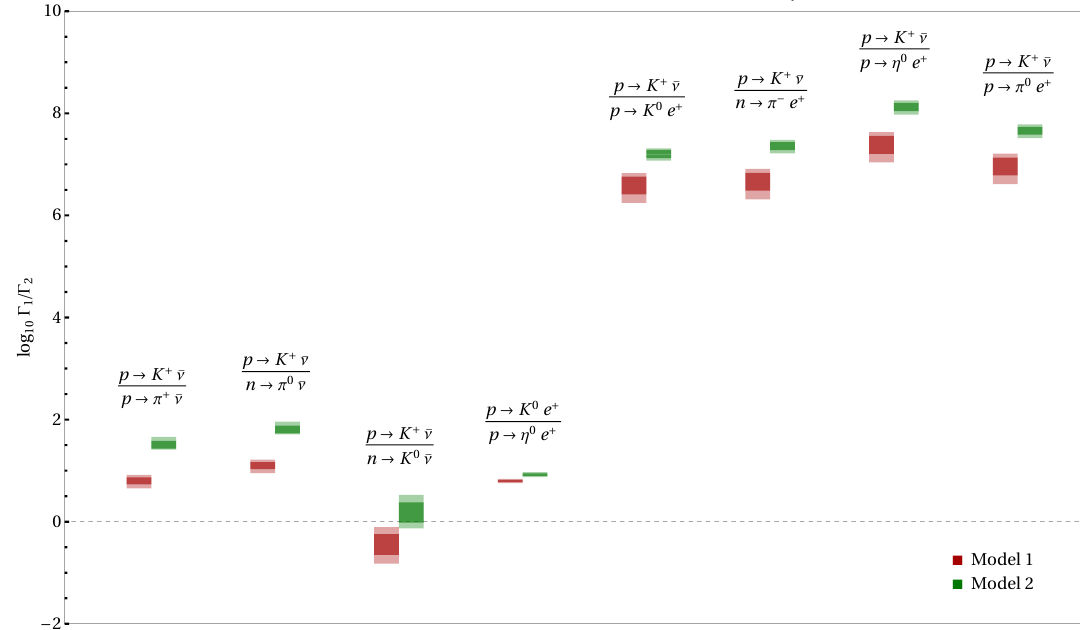
Figure 5 . The 1 - σ (dark) and 2 - σ (light) HPD regions predicted via MCMC for selected ratios of decay rates of two channels; we assume the same cMSSM benchmark point in both